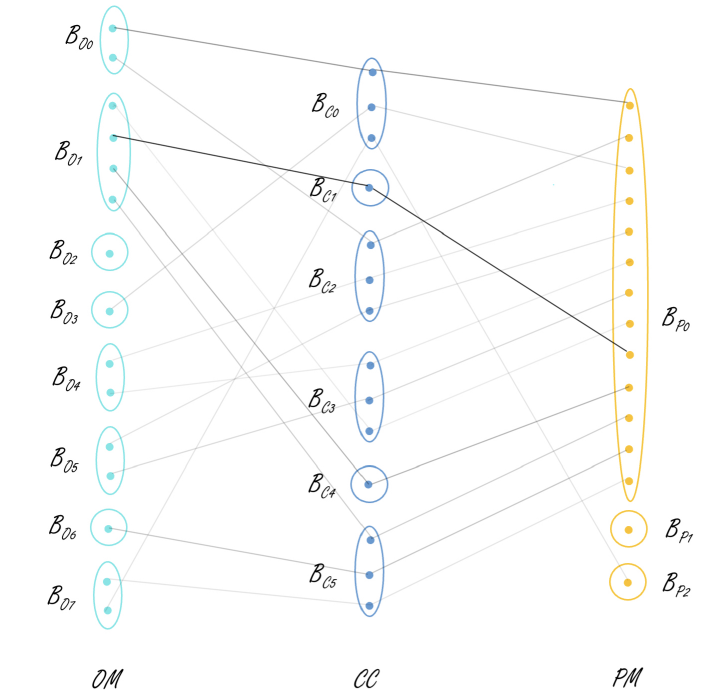
Figure 5. Tripartite graph representing the relationships between different concepts after receiving chunk 3. Color thickness of the edges correlates to the size of the concept.